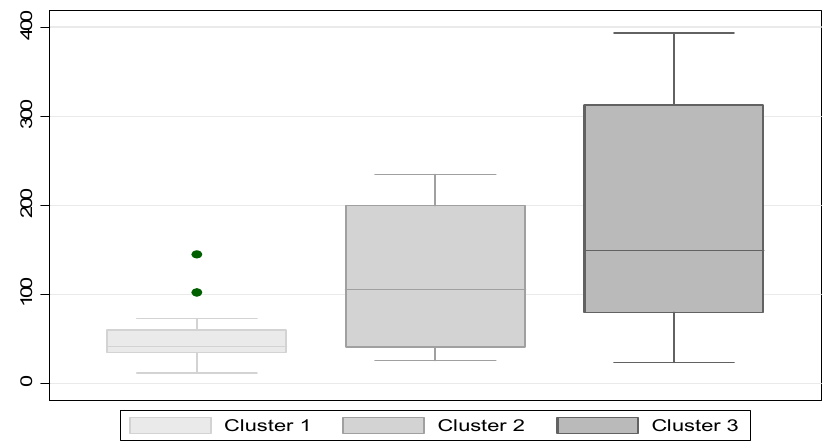
Figure 2. Partial Productivity of labor in the three clusters across European countries; Source: [34] and own calculations . Table 3. Defining and re-naming the three clusters of European countries through the composite indicator of farm structure; Source: own calculations .